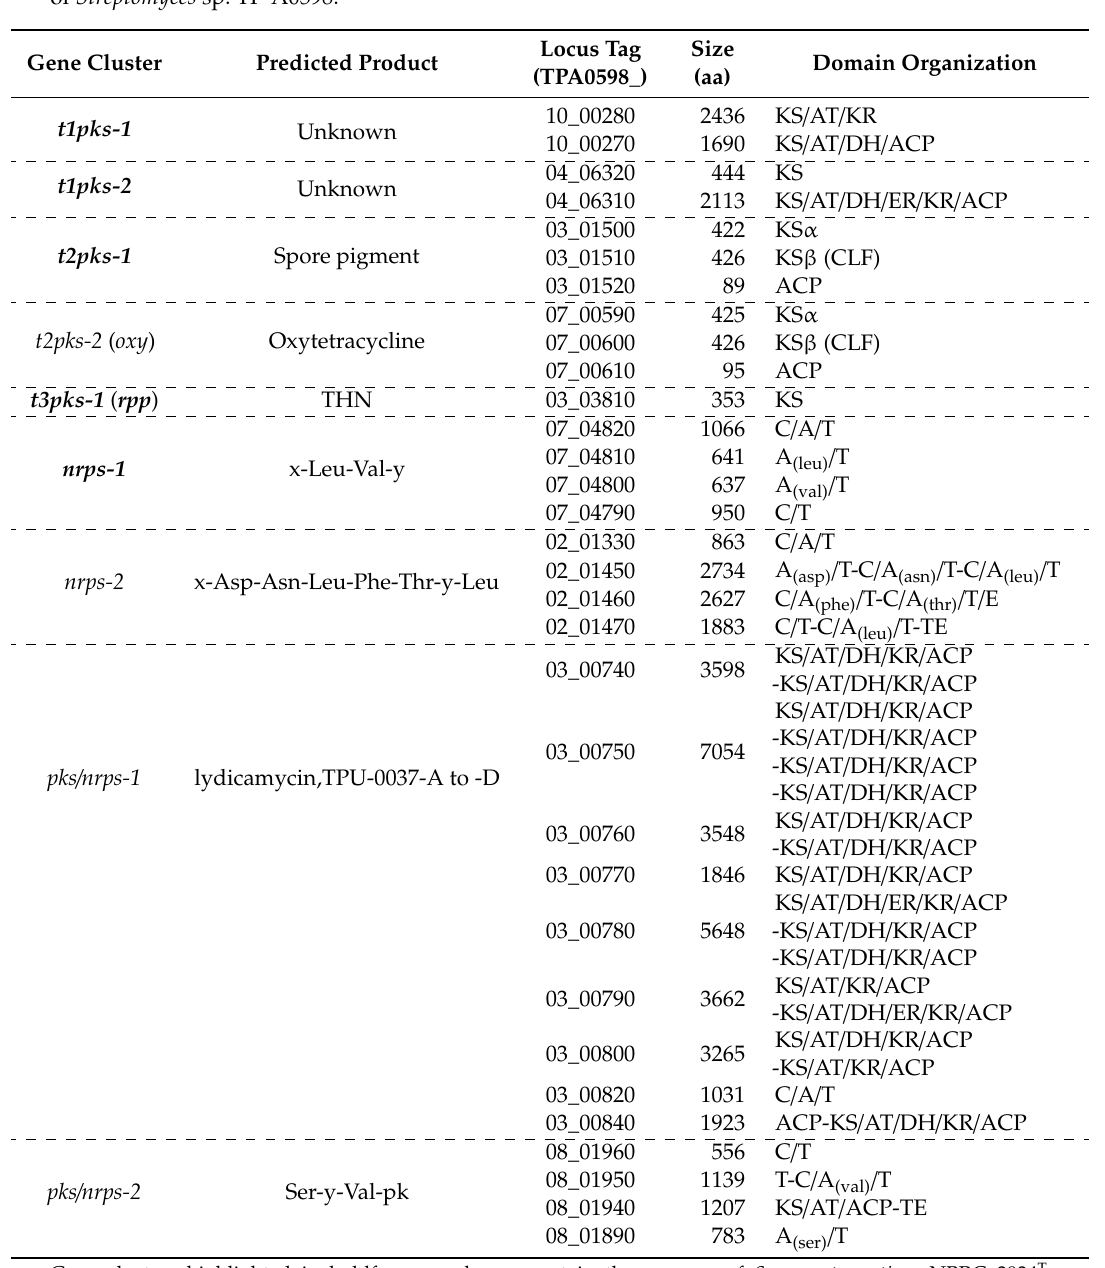
Table 3. Polyketide synthase (PKS) and nonribosomal peptide synthetase (NRPS) in the gene clusters of Streptomyces sp.